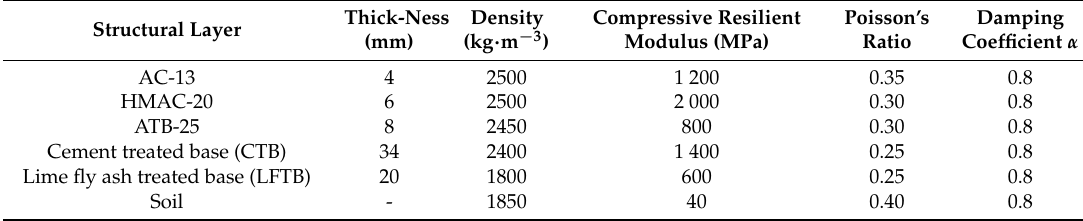
Table 4. Material parameters of HMAC pavement.